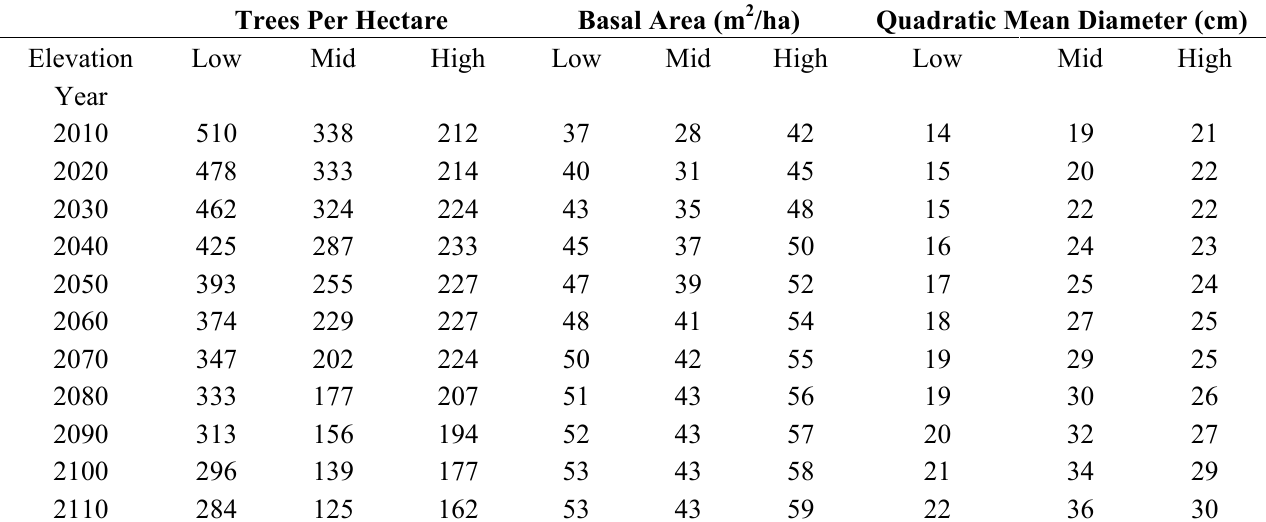
Table 3. Projected stand conditions under no climate change and no management. Trees Per Hectare Basal Area (m 2 /ha) Quadratic Mean Diameter